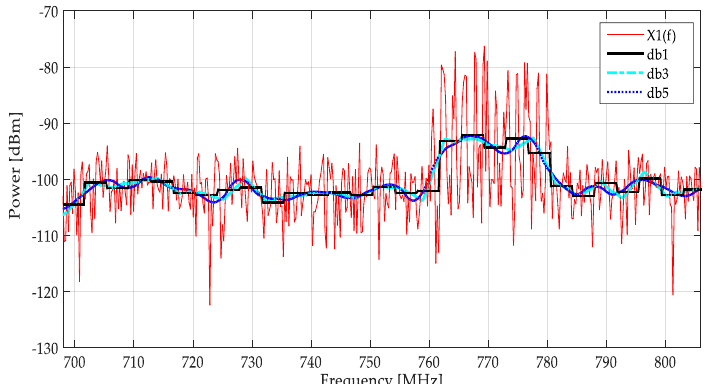
Figure 12. A real spectrum (in red) and the approximated signals from MRA using a Daubechies wavelet family.